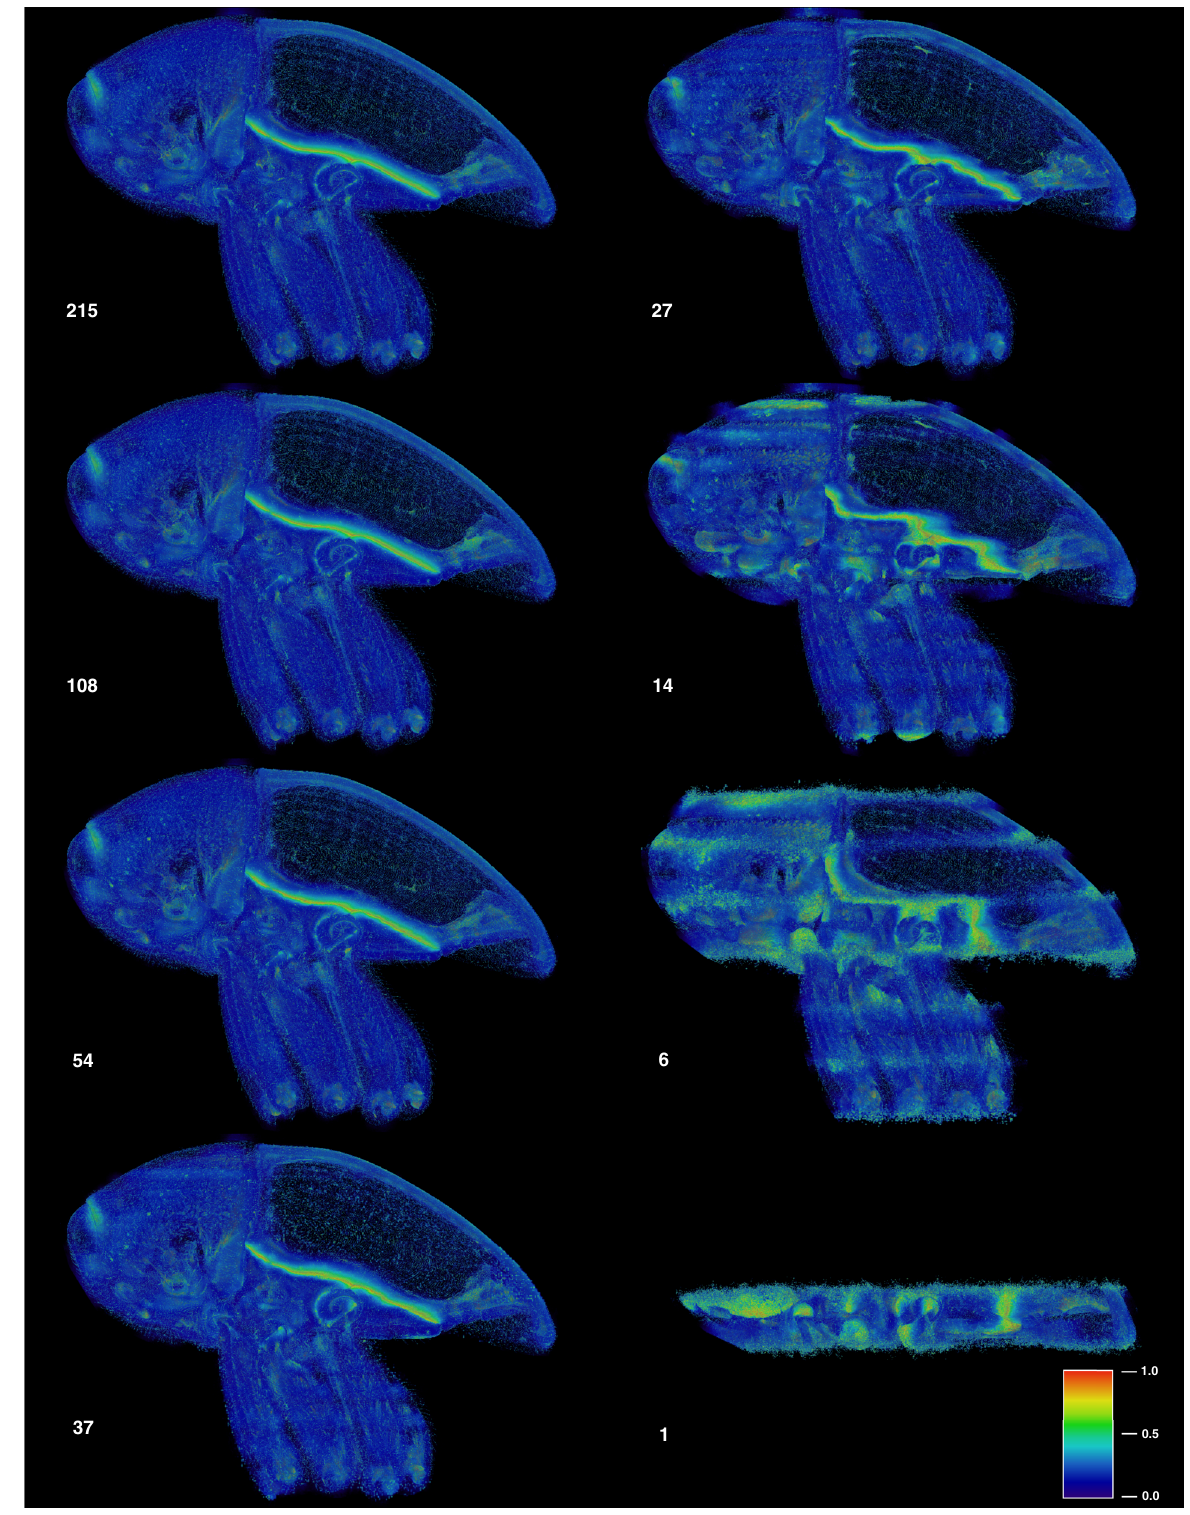
Fig. 4 Uncertainty of Biomedisa results based on different numbers of pre-segmented slices. For 215, 108, 54 and 37 pre-segmented slices, the results show approximately the same degree of uncertainty, while for 27 or fewer slices the uncertainty increases signi fi cantly. The conspicuous bright line represents the boundary between elytra and thorax, which are closely interlocked. The boundary is almost invisible in the tomographic scan, thus resulting in a high uncertainty of the segmentation result. The uncertainty values range from 0 (blue) to 1 (red), with 0 meaning no uncertainty and 1 meaning a high degree of uncertainty, i.e. a voxel can be assigned to at least two labels with the same